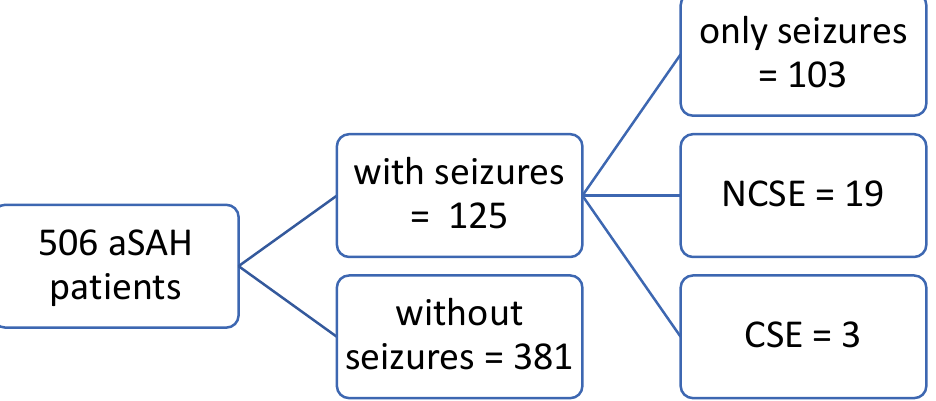
Figure 1. Characteristic of the cohort considering the seizure development.